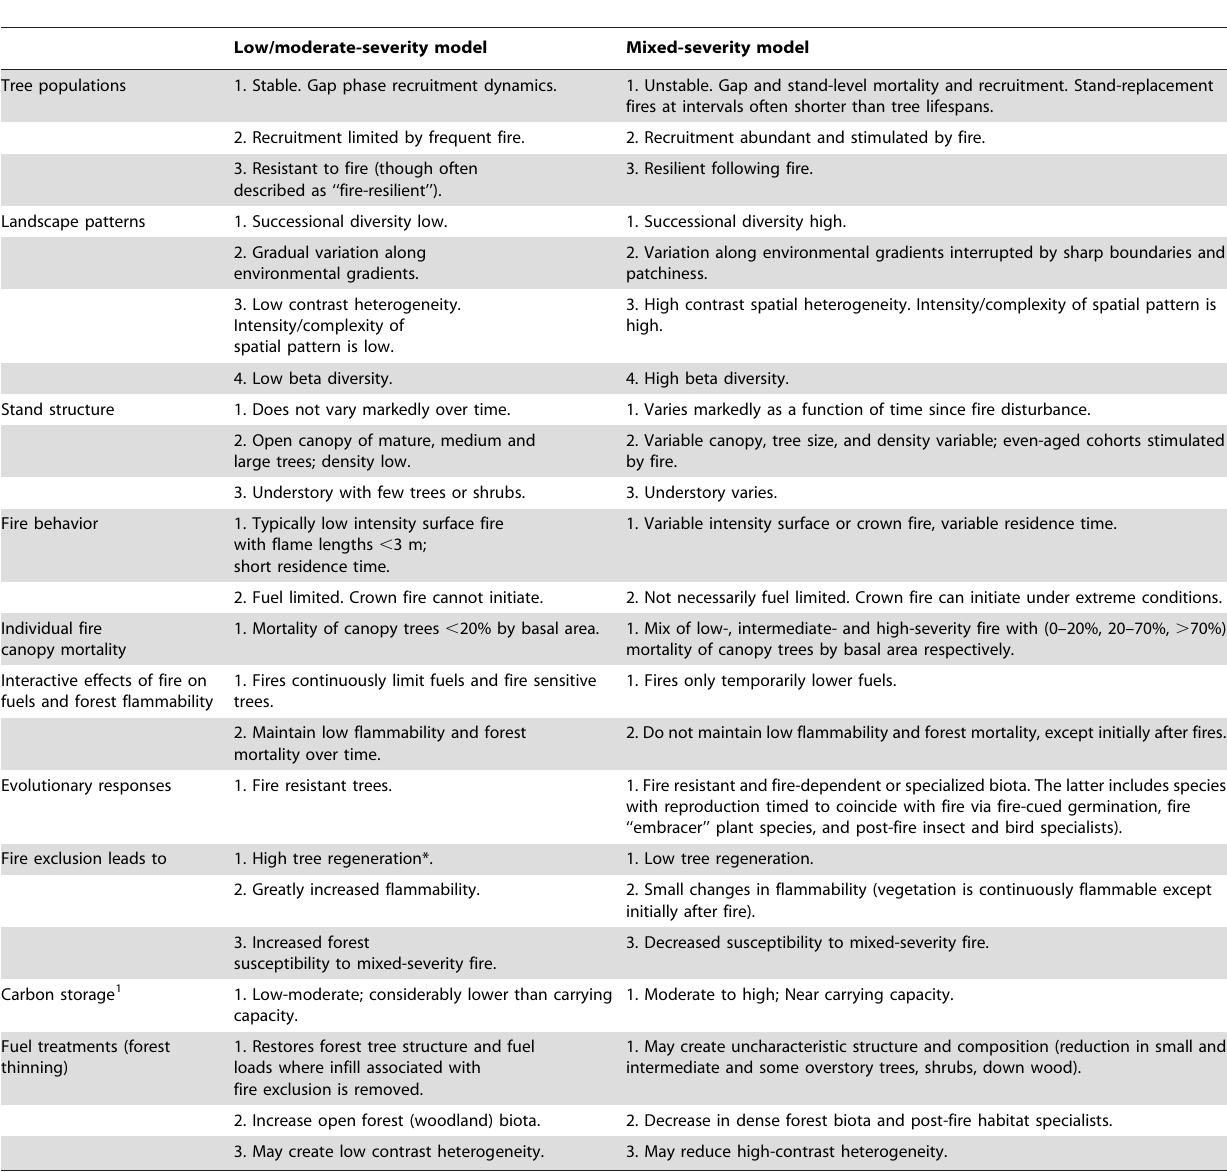
Table 2. Characteristics of fire regimes in ponderosa pine and mixed-conifer forests of Western North